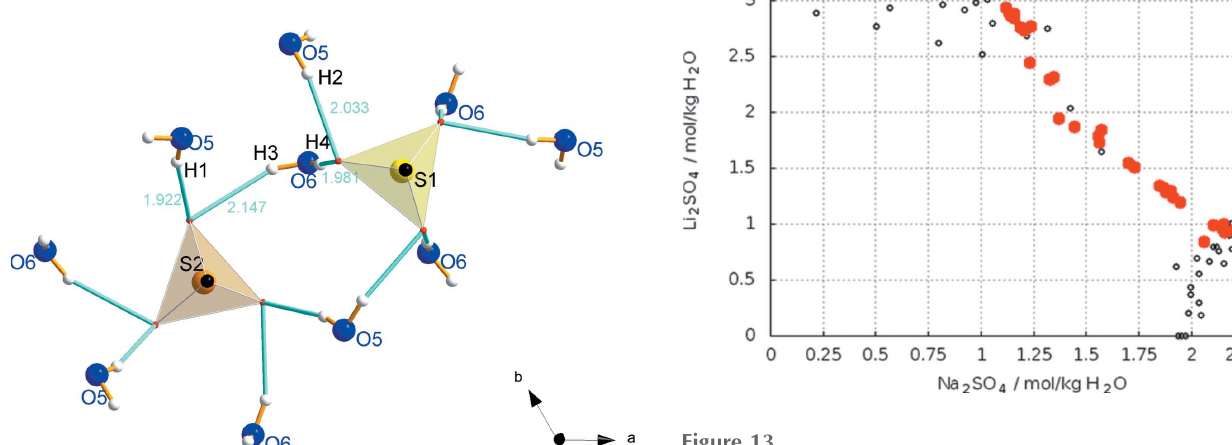
Figure 13 Solubility data in the system Li 2 SO 4 –Na 2 SO 4 –H 2 O at 298 K (Sohr et al. , 2017). Crystallization points of LiNa 3 (SO 4 ) 2 (cid:2) 6H 2 O are shown in red.